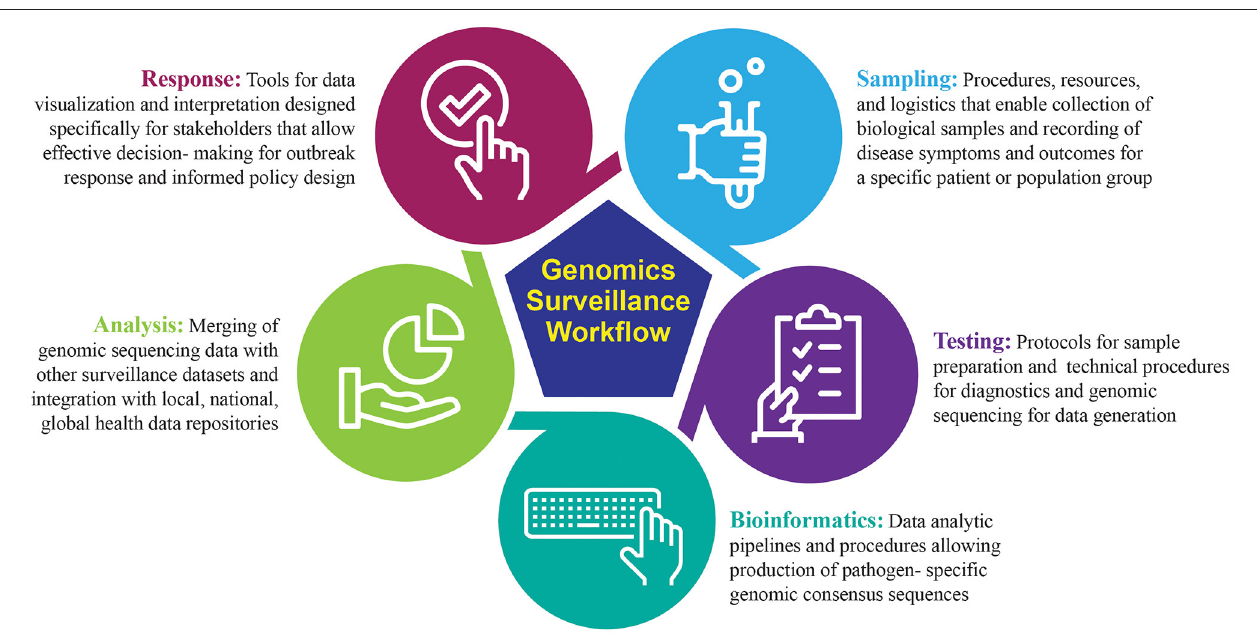
FIGURE 1 | Overview of end-to-end genomics-based surveillance